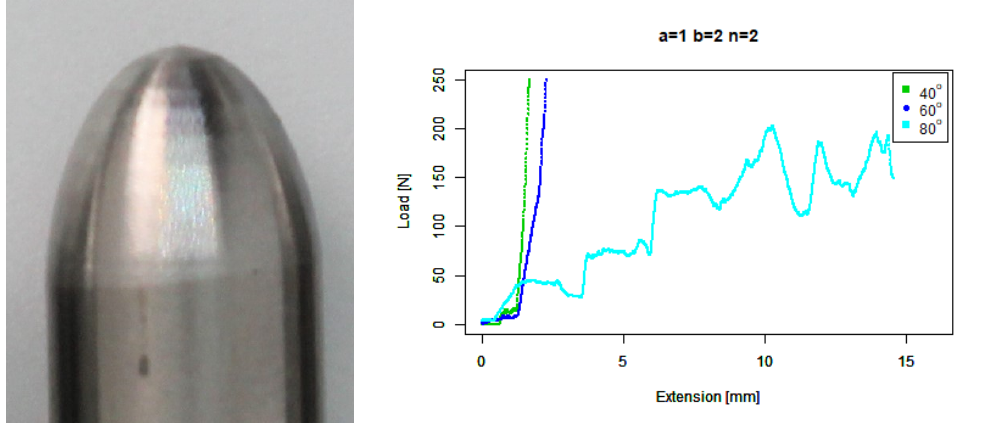
Figure 14. Extruded round tip. ( Left ) Tip Profile. ( Right ) Experimental characterisation.